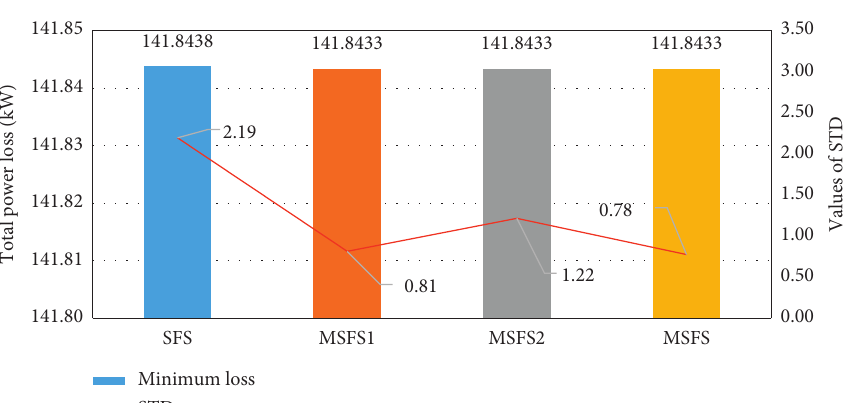
Figure 3: Minimum power loss and standard deviation of 50 trial runs obtained by SFS methods for case 1 of the 33-bus